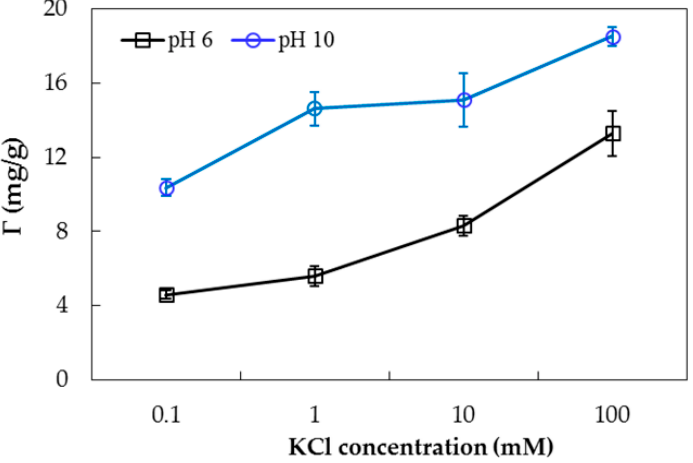
Figure 7. Effect of KCl concentration on PDADMAC adsorption on nanosilica ( C i (PDADMAC) = 1.0 g/L M, adsorbent dosage 10 mg/mL). Error bars show standard deviations of three replicates.